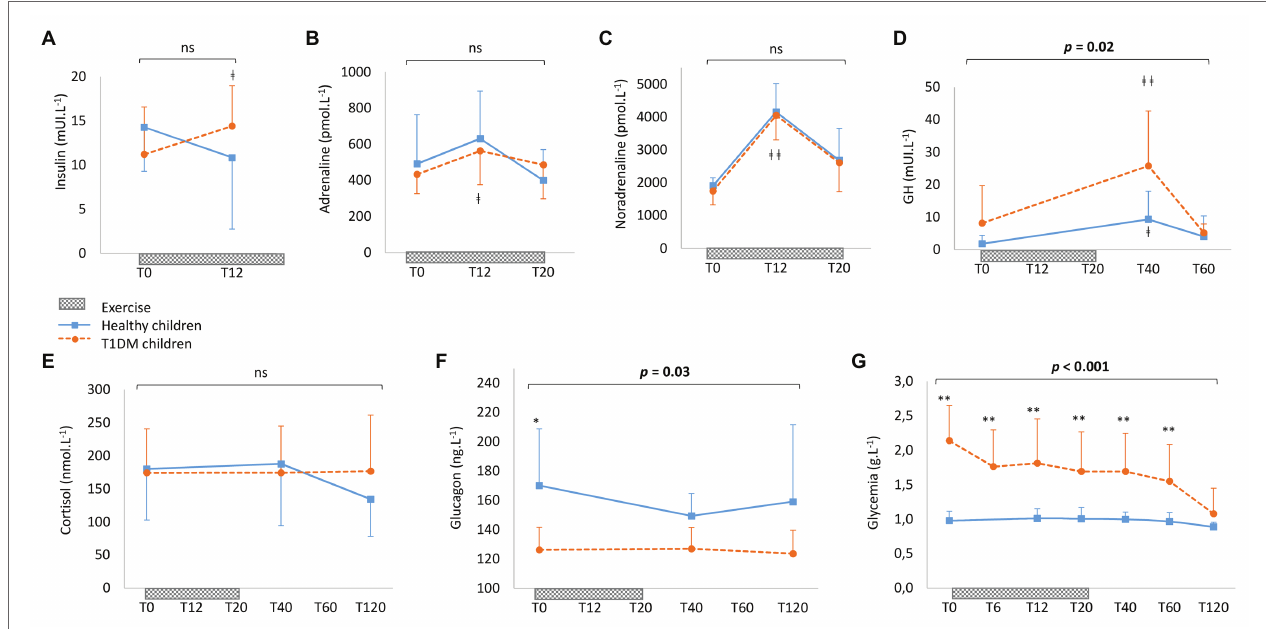
FIGURE 4 | Blood concentrations of insulin (A) , adrenaline (B) , noradrenaline (C) , growth hormone (D) , cortisol (E) , glucagon (F) , and glycemia (G) in healthy controls (solid line) and children with T1DM (dotted line). Incremental exercise starts at T0 and finishes at T20. Data are means ± SD. ∗ Significantly different between healthy controls and T1DM children at p < 0.05. ∗∗ Significantly different at p < 0.001. ǂ Significantly different from T0 at p < 0.05. ǂ ǂ Significantly different from T0 at p < 0.001.